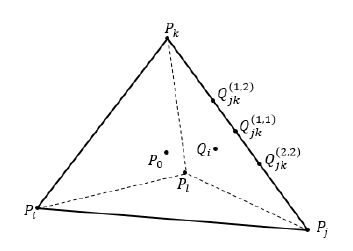
Figure 1. Nodal points for C 1 -ˇZen´ıˇsek finite